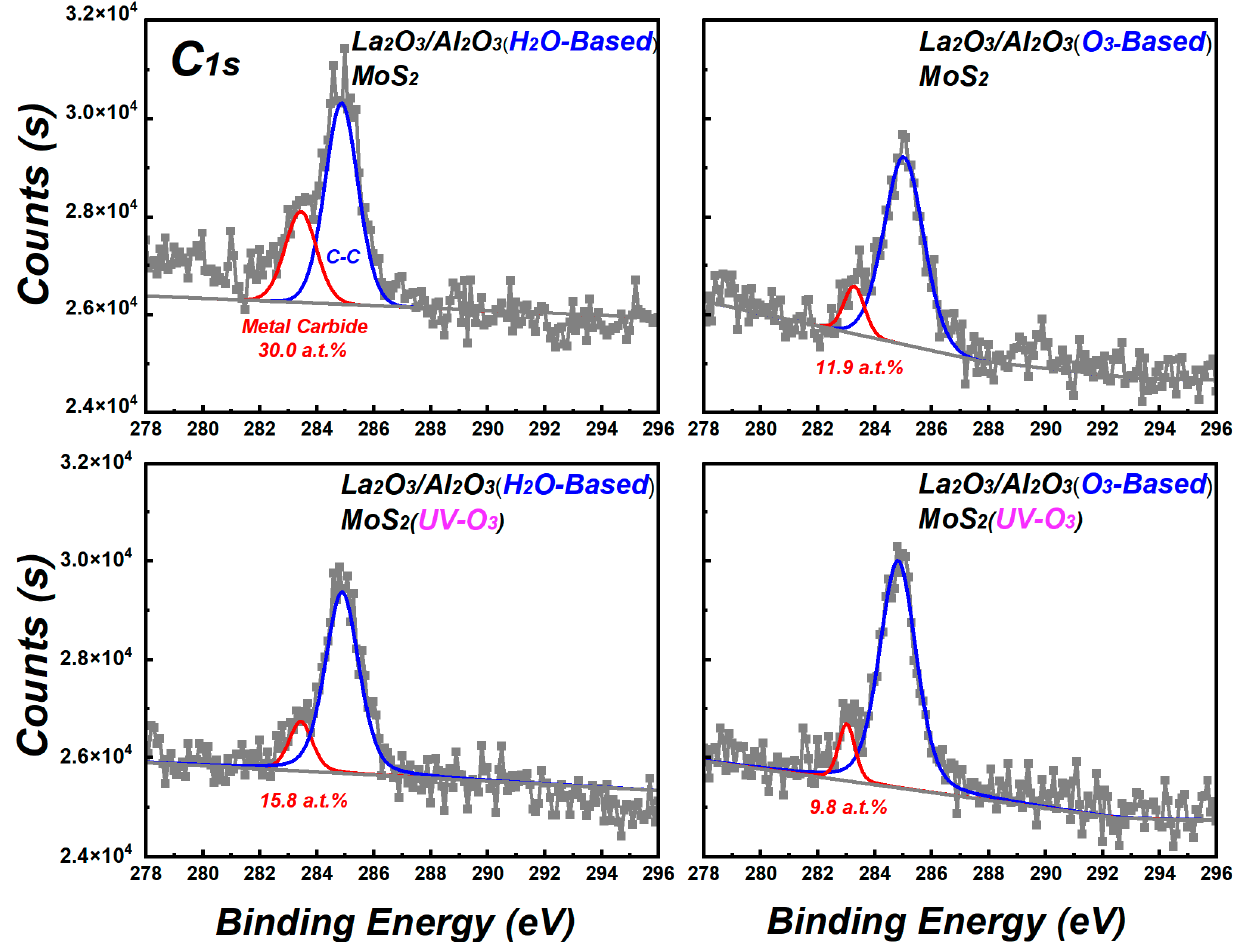
Figure 4. C 1s spectra of La 2 O 3 /Al 2 O 3 nanolaminates on MoS 2 .